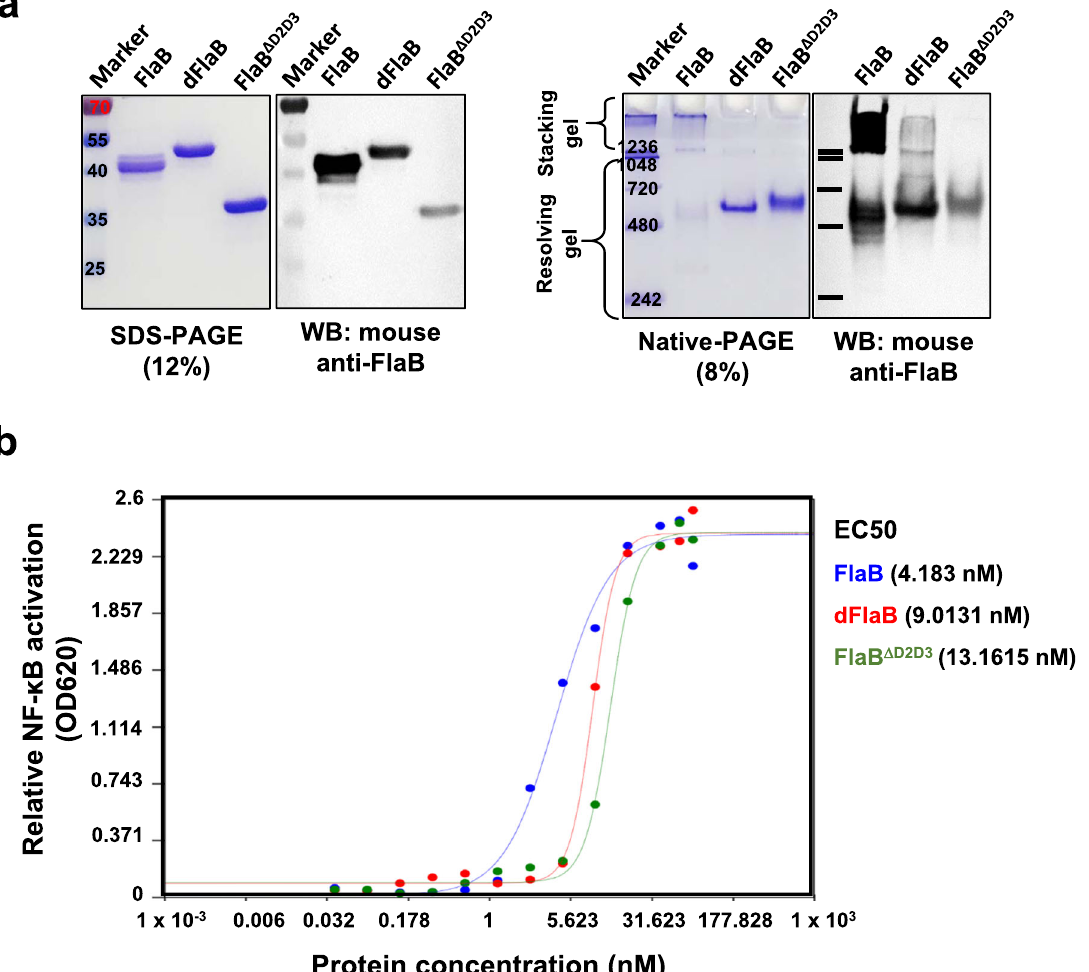
Fig. 2 Characteristics of the recombinant proteins. a Characterization of dFlaB and FlaB Δ D2D3 by sodium dodecyl sulfate polyacrylamide gel electrophoresis (SDS-PAGE), native-PAGE, and subsequent Western blot analysis with mouse anti-FlaB serum induced by intraperitoneal immunization of FlaB formulated complete Freund ’ s adjuvant. b Determination of TLR5-dependent NF- κ B stimulating activity by FlaB, dFlaB, and FlaB Δ D2D3 . The relative NF- κ B activities were analyzed by using HEK-Blue TM hTLR5 cells and HEK-Blue TM detection assay systems. EC50 were calculated using triplicate OD 620 nm values for each protein concentration over a wide range of protein concentrations (0.03719 nM to 76.16 nM at the AAT Bioquest website (https://www.aatbio.com/tools/ec50-calculator). The same molar ratio of proteins was used, and PBS was used as a negative